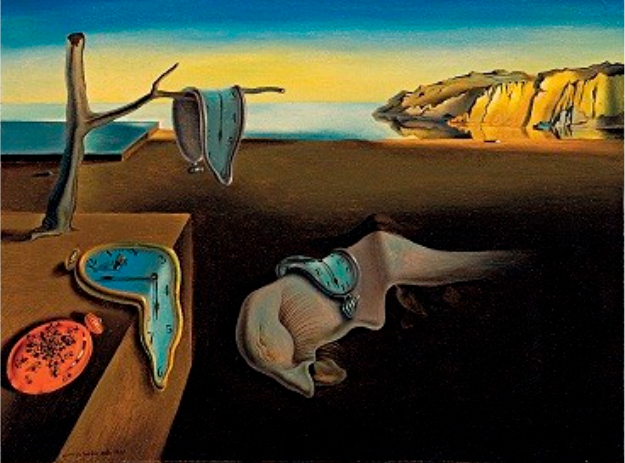
Figure 1. “The Persistence of Memory” by Salvador Dalí.